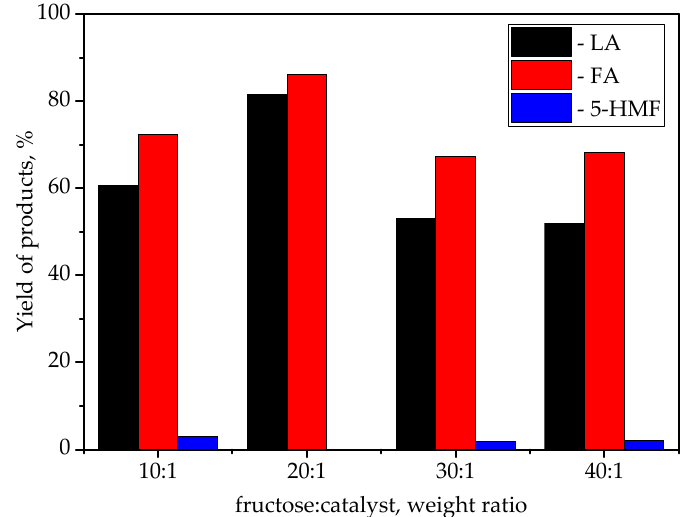
Figure 6. Effect of catalyst concentration on the yield of the reaction products. Reaction conditions: fructose (2 g, 11.1 mmol, 20 wt.%), H 2 O (10 mL), ZrO 2 –SiO 2 –SnO 2 catalyst at 180 °C for 5 h.